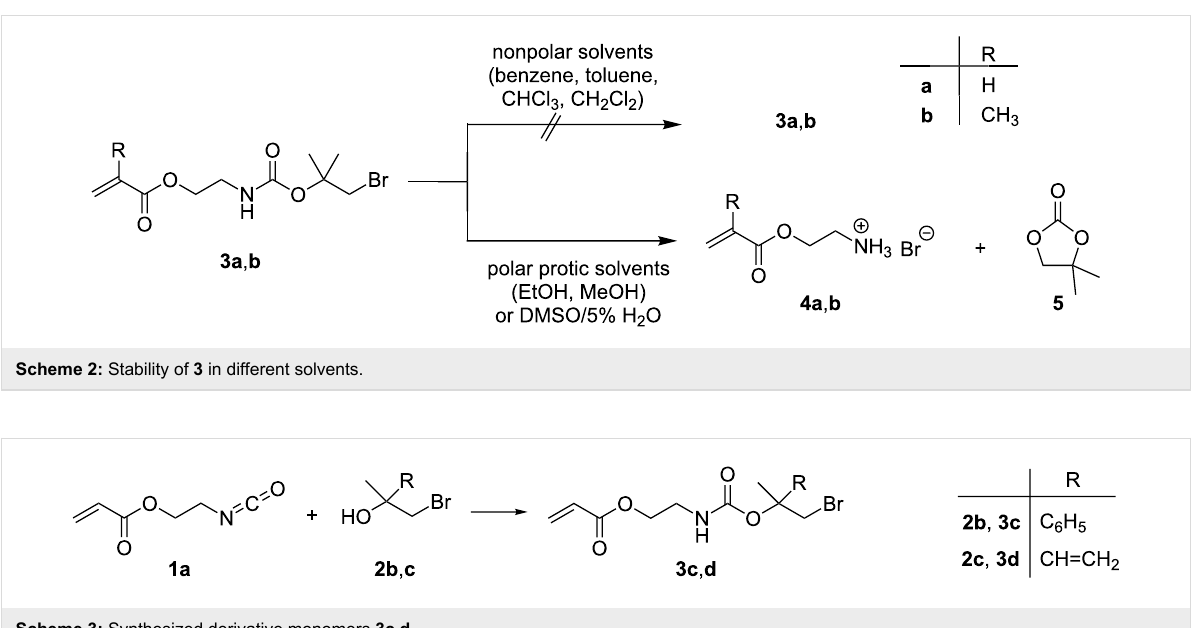
Scheme 3: Synthesized derivative monomers 3c , d .